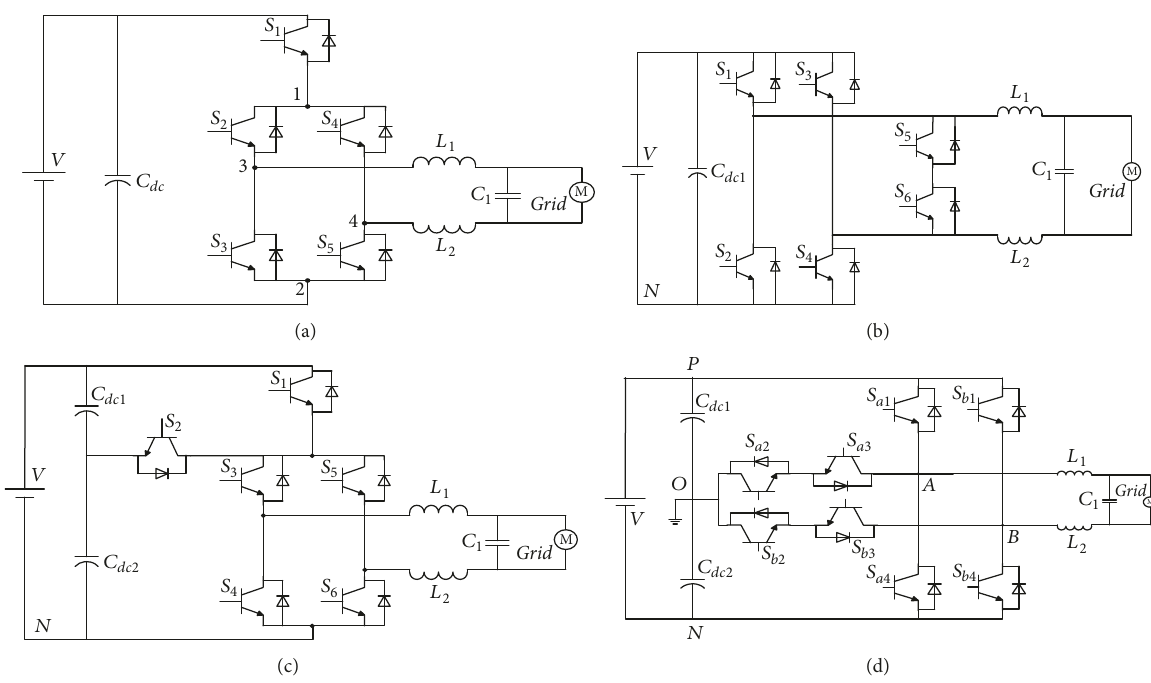
Figure 5: Some new topology structure. (a) H5 topology, (b) Heric topology, (c) OH5 topology, and (d) T-type